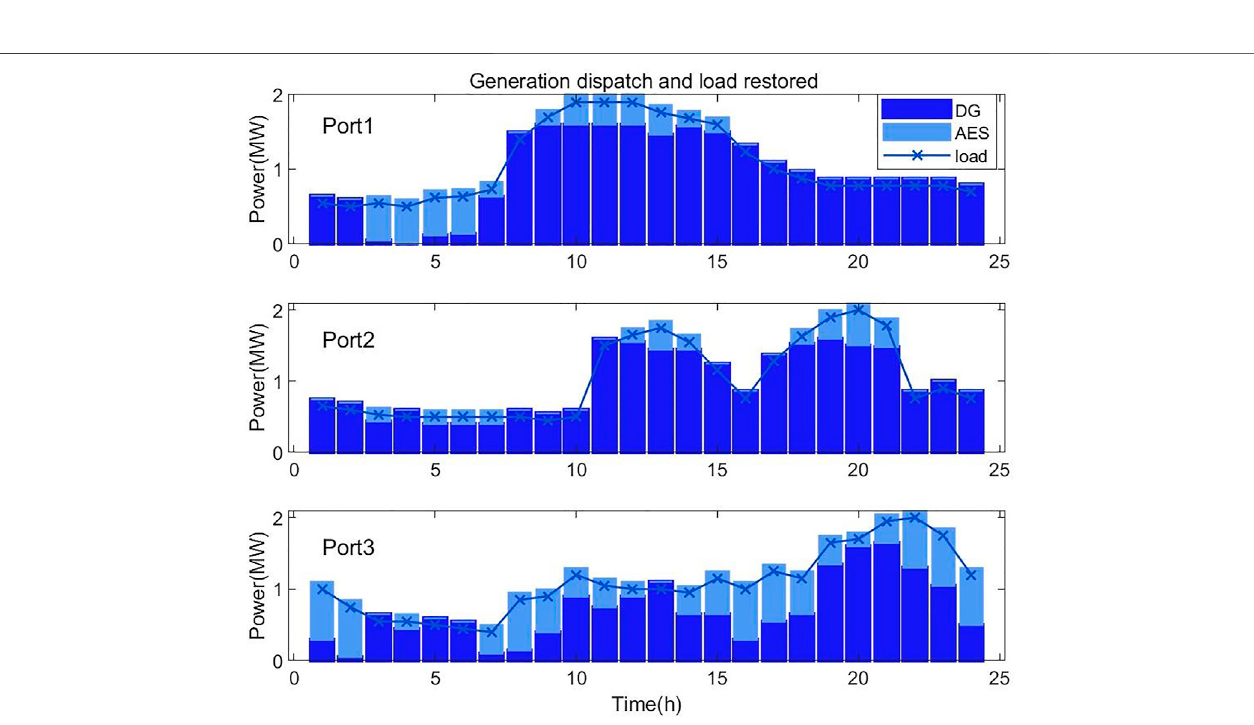
FIGURE 6 | Generation Dispatch and Load Restored in case 2.